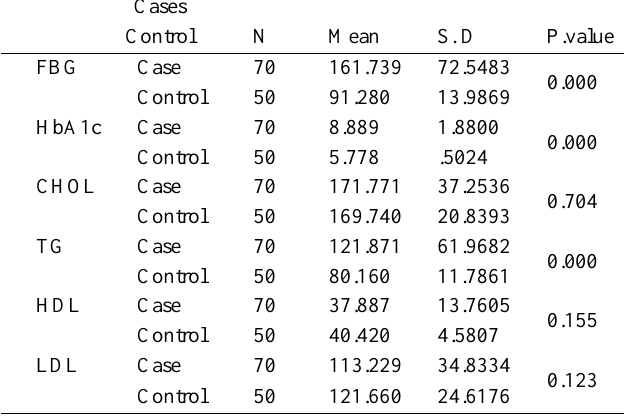
FBG:Fasting Blood glucose HbA1c:Glycated hemoglobin CHOL: Total cholesterol TG: Triglycerides HDL: High density lipoprotein LDL: Low density